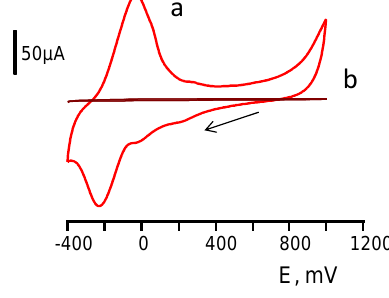
Figure 2. Cyclic voltammograms from 1000 to −400 mV of THI/rGO/SPCE ( a ) andrGO/SPCE ( b ) in a 0.1 mol L −1 phosphate buffer solution of pH 7.0. See the text for more information.